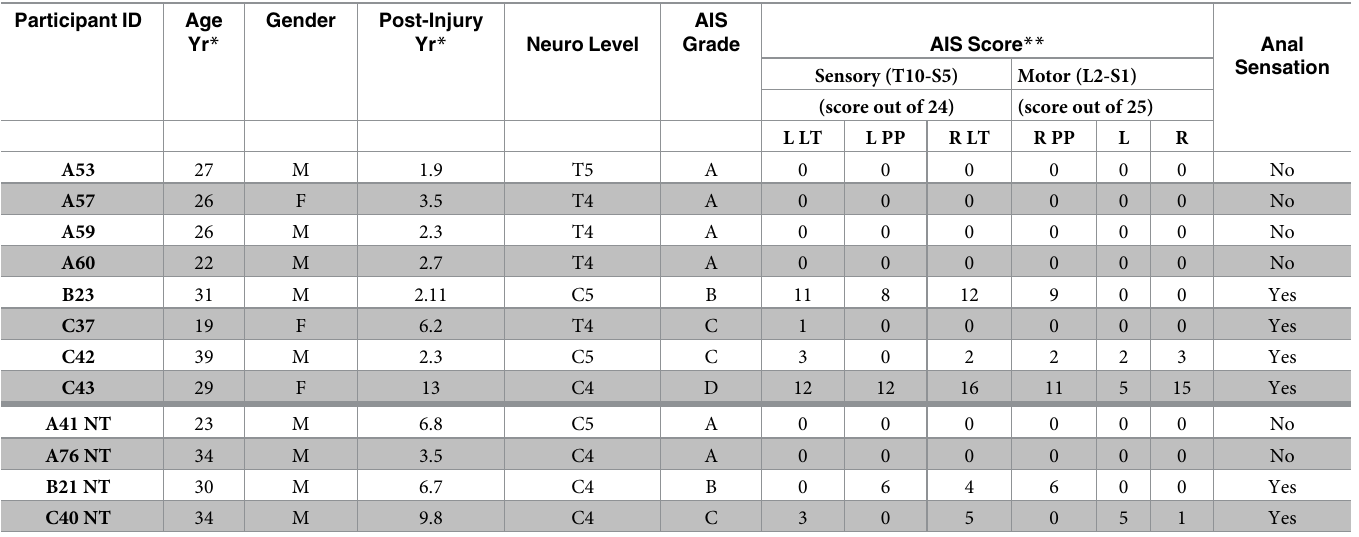
Table 1. Clinical characteristics of research